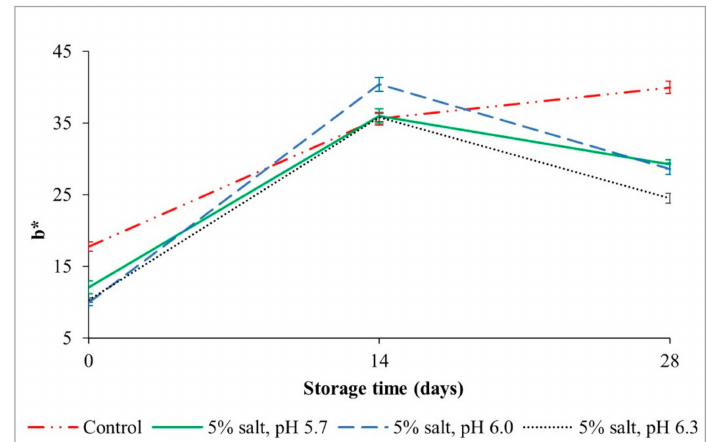
Figure 5. The effect of treatment on b* (CIE yellow(+)/blue( − ) colour attribute [32]) of frozen-thawed liquid egg yolk. Data are presented with mean ± standard